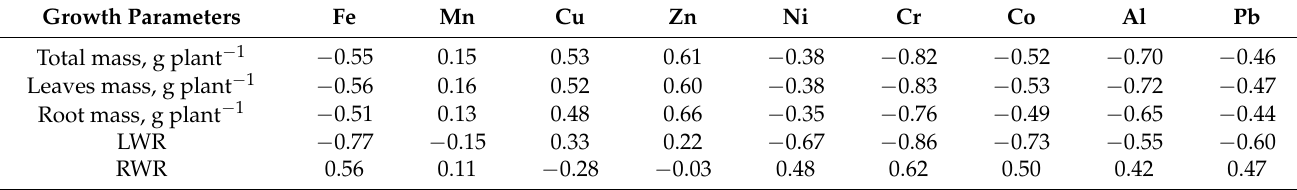
Table 3. Correlation coefficients between plant growth parameters and microelements content in leaves of cucumber